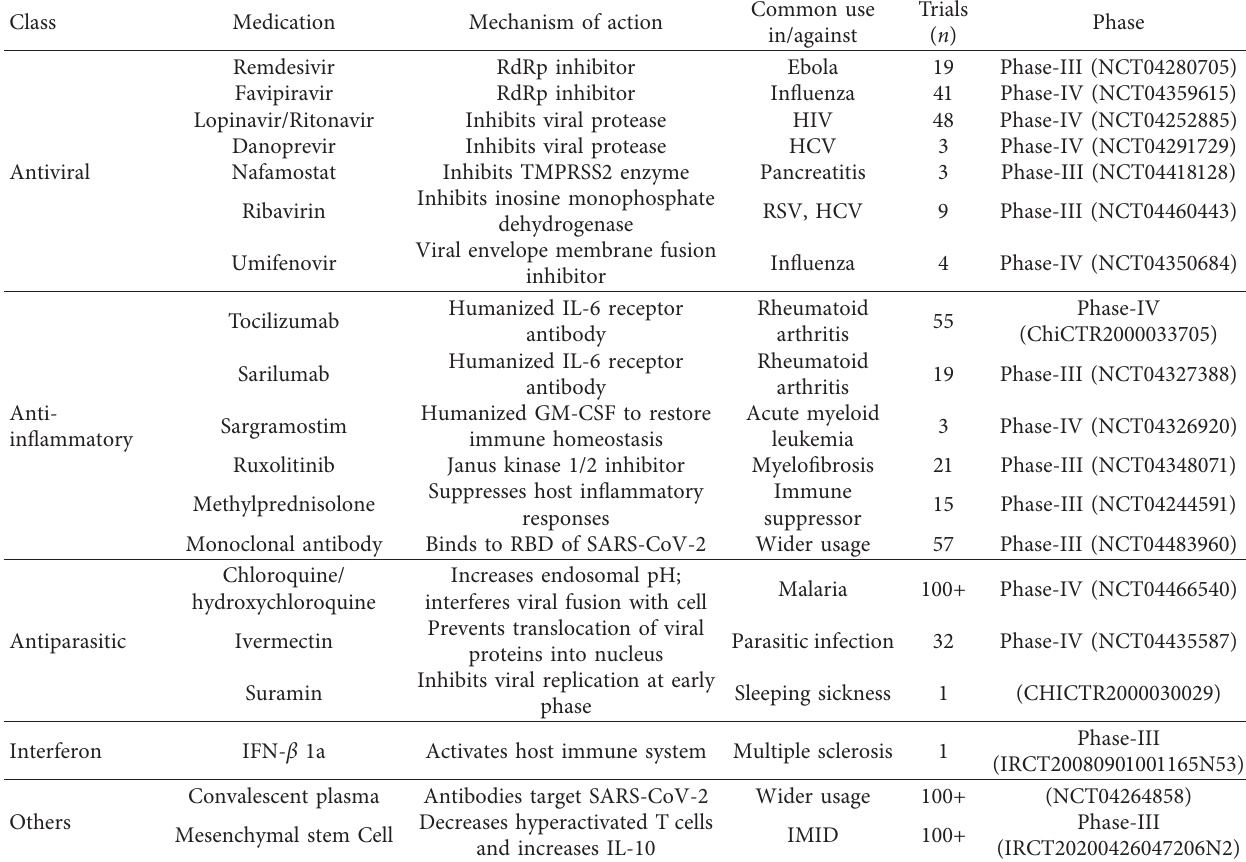
Table 2: Current therapeutic options for